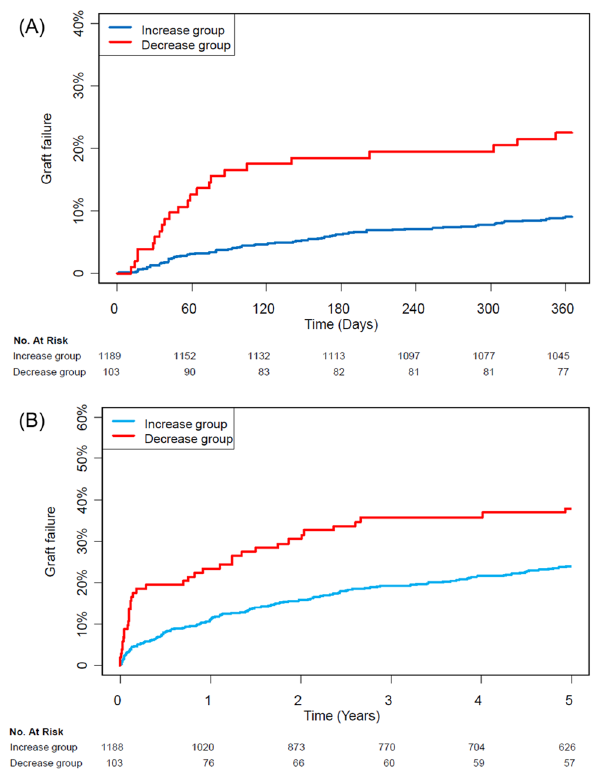
Figure 2. Kaplan Meier curves for graft failure during ( A ) 1-year follow-up and ( B ) overall